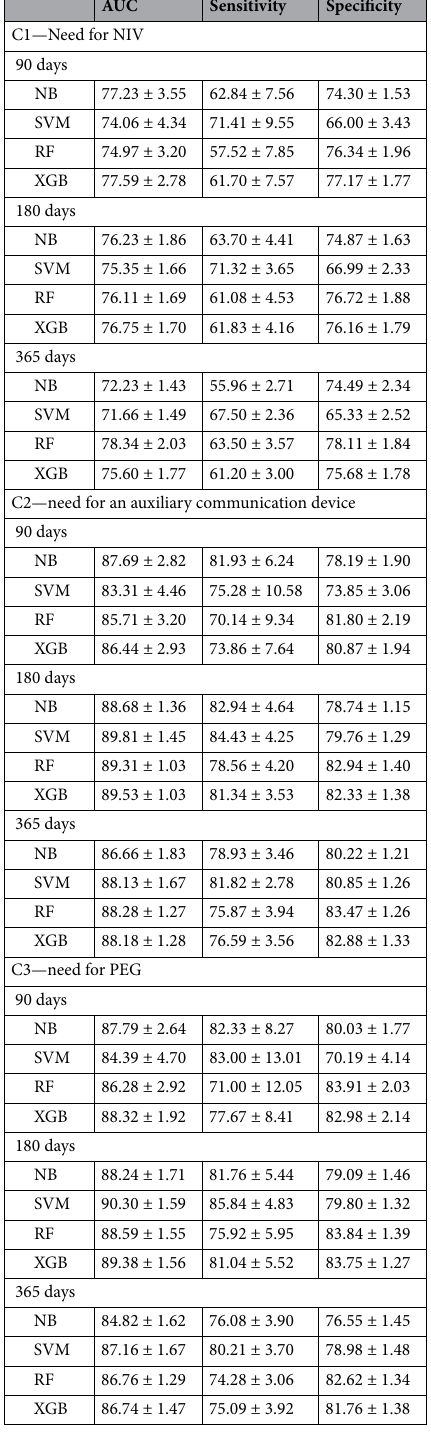
Table 6. Baseline results using data preprocessed following the approach proposed by Carreiro et al. 12 learned with 4 classifiers: Naive Bayes (NB), Support Vector Machine (SVM), Random Forests (RF) and XGB (eXtreme Gradient Boosting) to predict the Evolution for each of the target endpoints, C1, C2, and C3, within the considered time windows (90, 180 and 365 days),